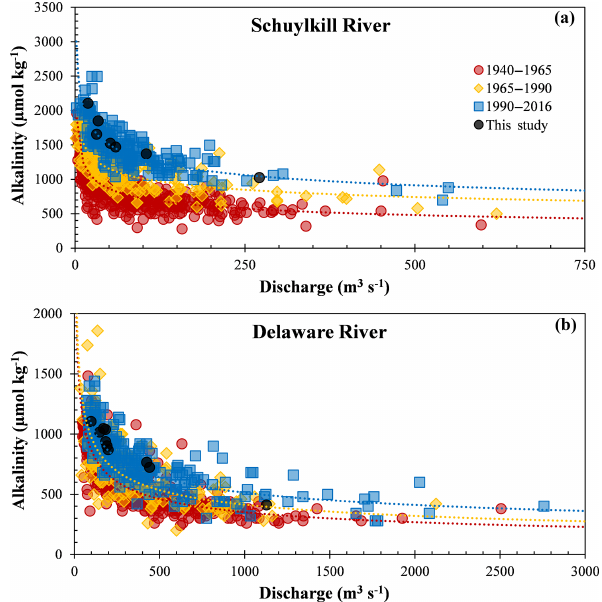
Figure 7. (a) Time series of the Schuylkill River discharge at Philadelphia, PA, and (b) the Delaware River discharge at Trenton, NJ, against alkalinity from 1940 to 2016. Note the different scales used for each